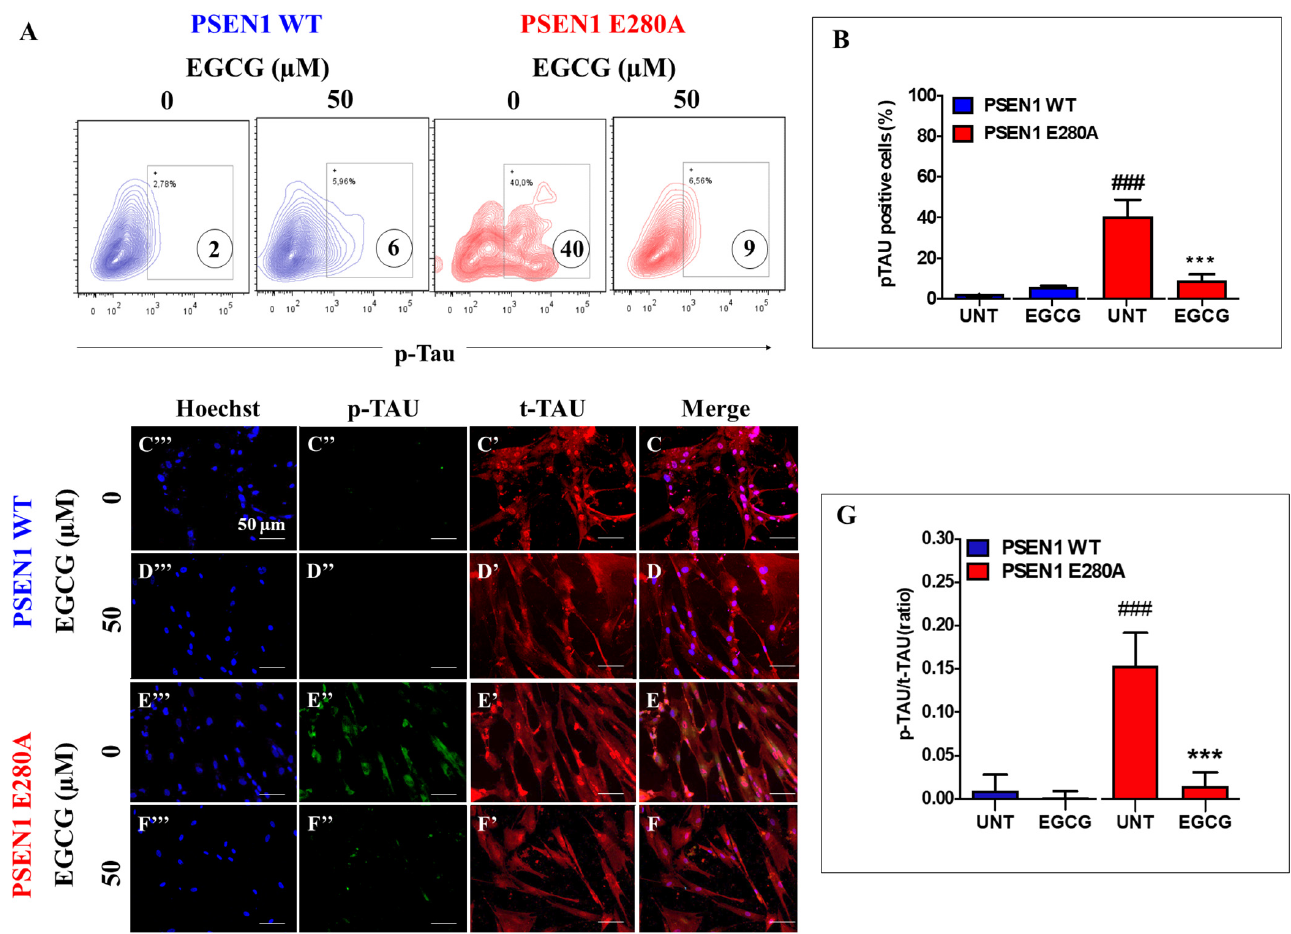
Figure 4. EGCG reduces the phosphorylation of TAU protein in PSEN1 E280A ChLNs. After 7 days of transdifferentiation, WT PSEN1 and PSEN1 E280A ChLNs were left untreated or treated with EGCG in a regular culture medium for 4 days. Then, the cells were labeled with primary antibodies against phosphorylated TAU (p-TAU), and fluorescent secondary antibodies. The fluorescent contour plot shown in ( A ) were quantified ( B ). Additionally, cells were double-stained as indicated in the figure ( C – F ) with primary antibodies against p-TAU (green; C’ – F’ ) and t-TAU (red; C’’ – F’’ ). The nuclei were stained with Hoechst 33,342 (blue; C’’’ – F’’’ ). ( G ) Quantification of the p-TAU/t-TAU fluorescence ratio. Data are expressed as the mean ± SD; ###, *** p < 0.001; ### represents differences compared to UNT PSEN1 WT cells; *** represents differences compared to UNT PSEN1 E280A cells. The figures represent 1 out of 3 independent